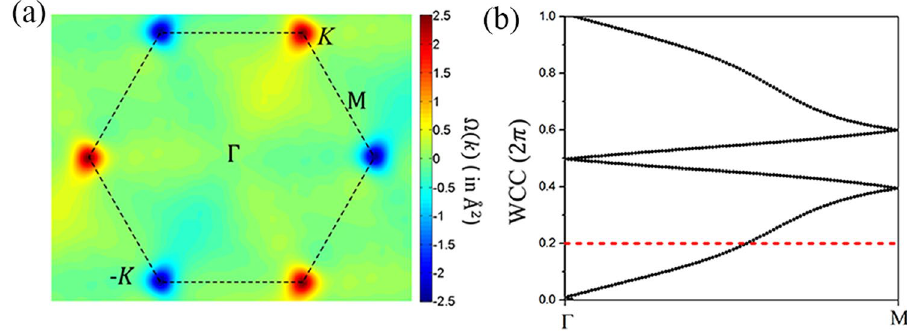
Figure 3. ( a ) The out-of-plane Berry curvature on k z = 0 plane in the momentum space of Bi 2 HF nanosheet. ( b ) The tracking of the evolution of the WCC between two time-reversal invariant momenta (TRIM) points in the reciprocal space k z = 0 plane. The dashed red line is a reference line to track the number of Wannier center pair.